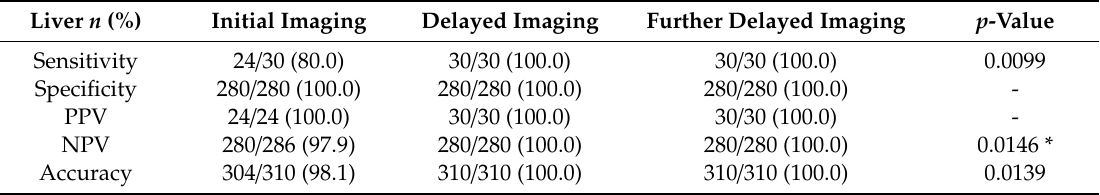
Table 3. Detection sensitivity, specificity, positive predictive value (PPV), negative predictive value (NPV) and accuracy for testing of only initial negative liver PET / CT images and delayed positive delayed PET / CT